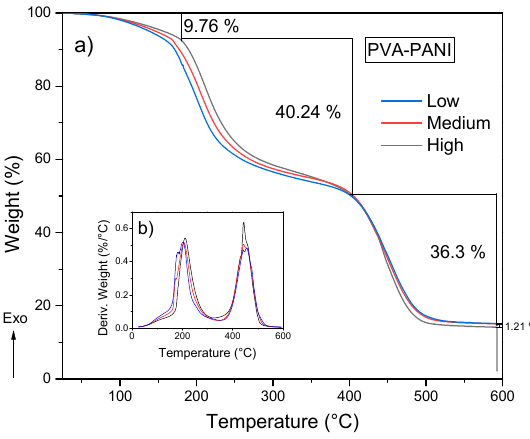
Figure 11. ( a ) TGA and ( b ) DTG of purified PVA–PANI gels at low, medium, and high concentrations of PANI.